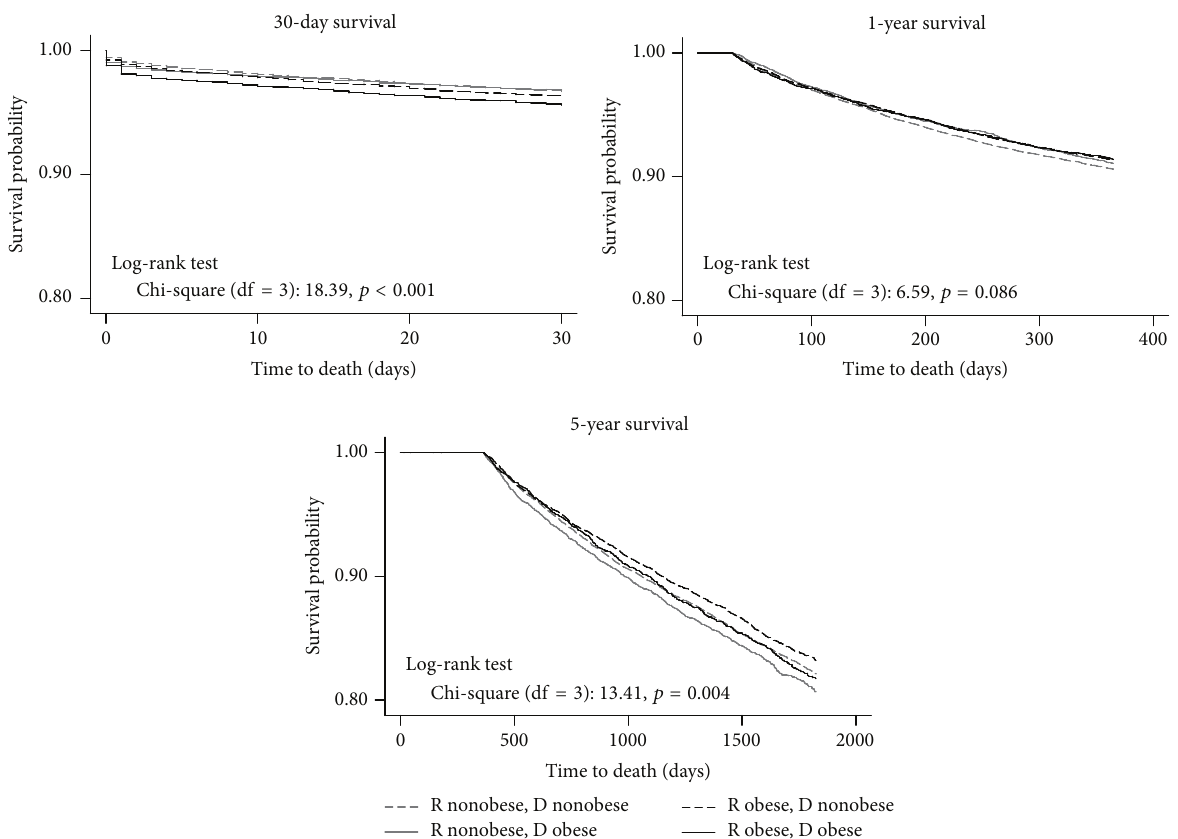
of overall survival indicated that there were no statistically significant differences by donor-recipient obesity match, but donor steatosis in the 20–30% range (HR = 1.16; 95% CI: 1.04, 1.29; 𝑝 = 0.010 ) and in the > 30% range (HR = 1.25; 95% CI: 1.03, 1.52; 𝑝 = 0.026 ) was associated with increased mortality relative to < 15% donor macrovesicular